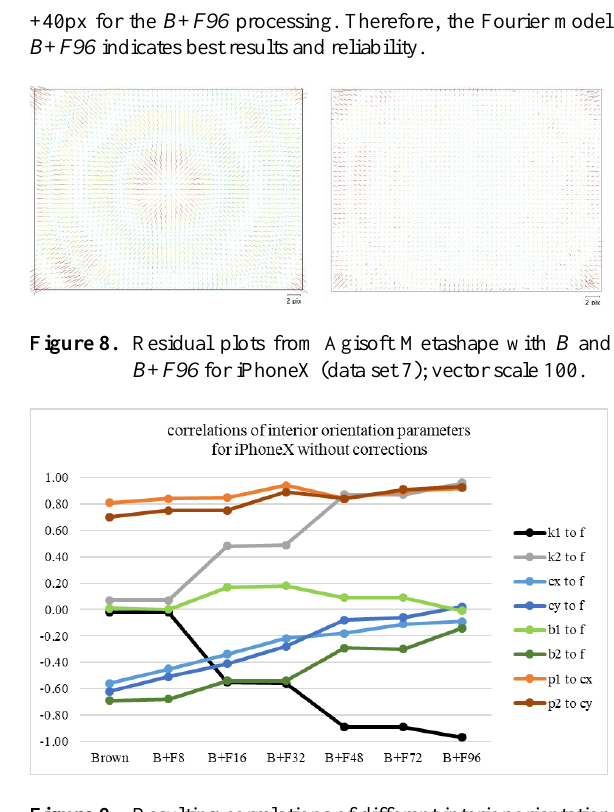
Figure 9. Resulting correlations of different interior orientation parameters for iPhoneX.